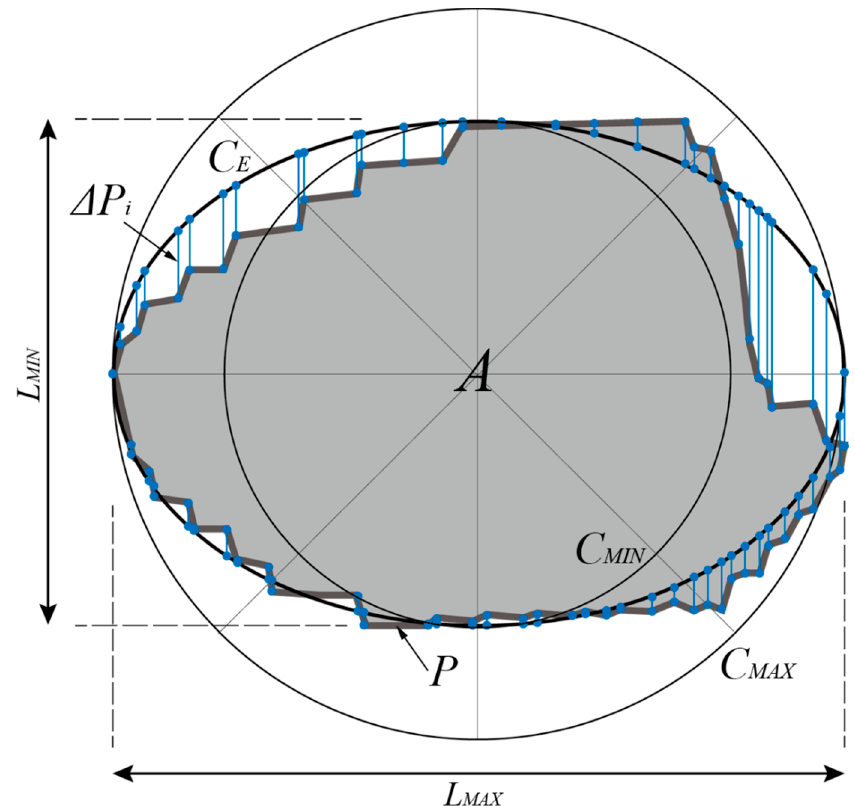
Figure 4. Schematic of 2D-projected snow particles detected using 2DVD. A is the projected area of the particle, and LMIN and LMAX are the minimum and maximum caliper lengths, respectively. C MIN and C MAX are circles with diameters of LMIN and LMAX , respectively. C E is an ellipsoid with LMIN and LMAX as the minor and major axes, respectively. P represents the projected outline coordinates of the particle, and Δ P i is the distance of the vertical coordinate between P i and C E,i .